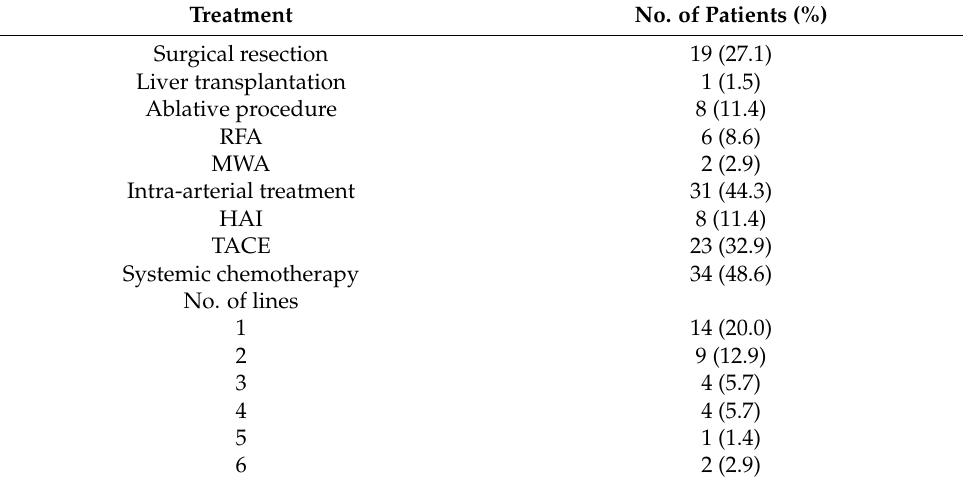
Table 2. Treatment before transarterial radioembolization